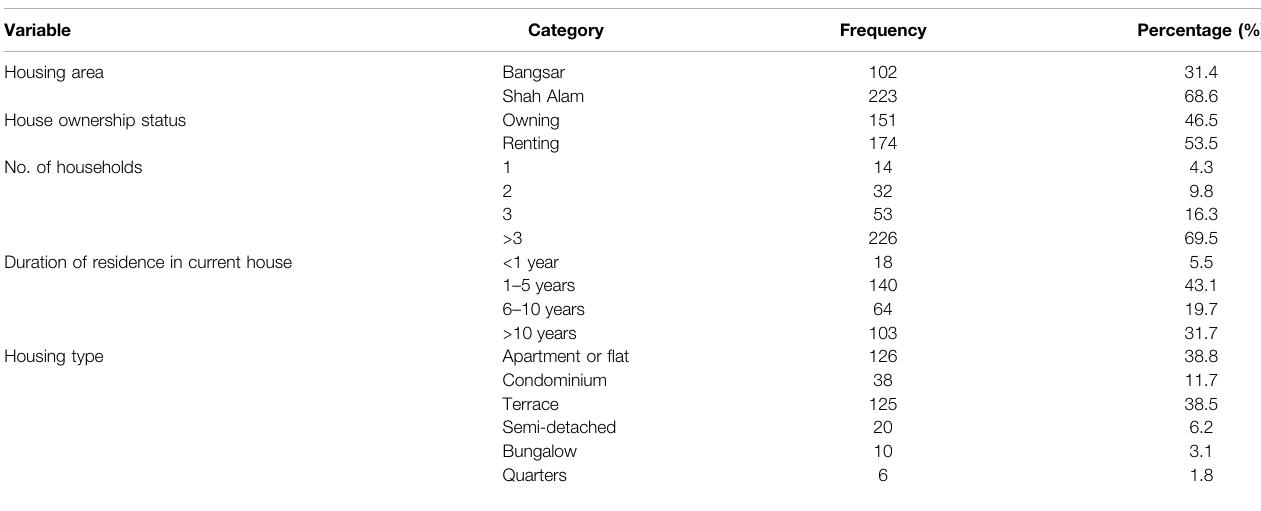
TABLE 2 | Respondents ’ housing information.